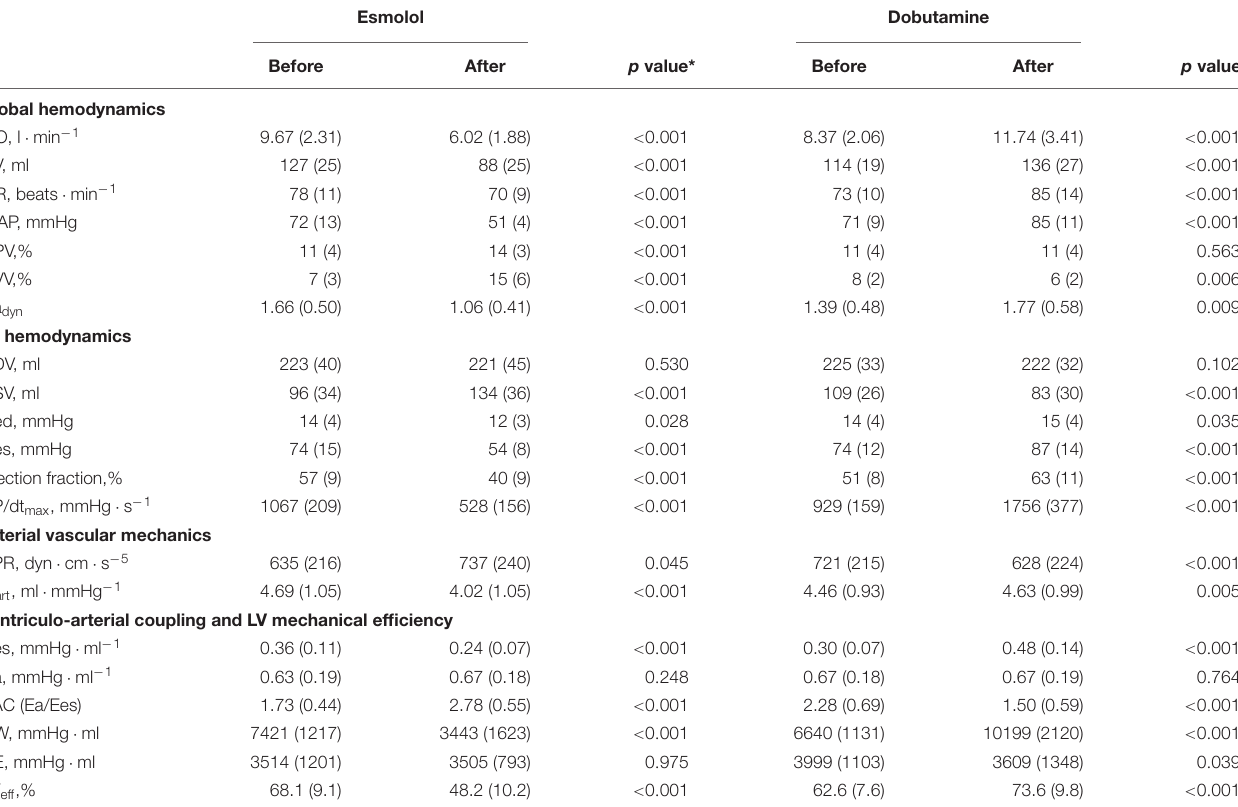
TABLE 3 | Hemodynamic variables during contractility changes.